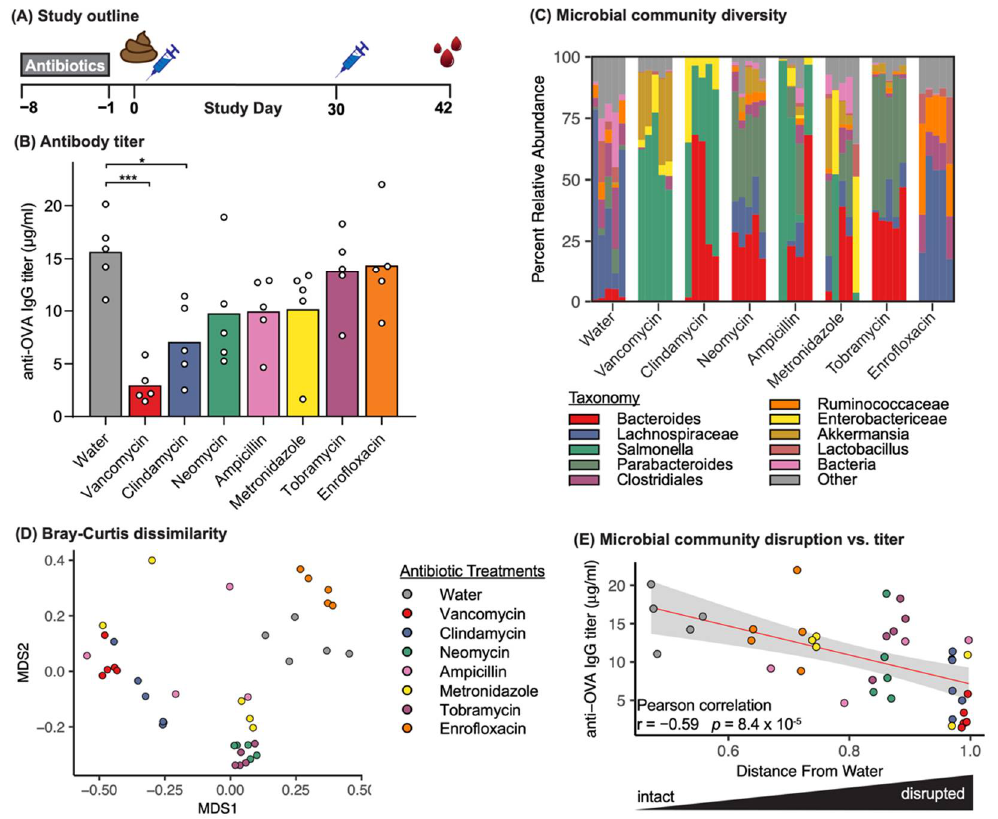
Figure 1. Oral administration of antibiotics differentially affects model sub-unit vaccine outcome and gut microbiome profiles. ( A ) Study design and dosing schedule. BALB/c mice were orally treated with antibiotics for seven days (gray rectangle), followed by a single day of no antibiotic treatment before a prime-boost OVA immunization regimen (blue syringes). Stool collection and harvesting of serum are indicated by brown stool and red icons, respectively. ( B ) Serum OVA-specific IgG titers at Day 42 after immunization. Measurements from individual mice (circles) are superimposed on group mean (bar). * p < 0.05, *** p < 0.001 compared to water by one-way ANOVA with Dunnett’s post hoc test. ( C ) Stacked bar plot of top 10 bacterial genera based on relative abundance determined by 16S rRNA gene sequencing of fecal samples collected at study day 0. Each column represents an individual mouse. ( D ) Non-metric multidimensional scaling (MDS) ordination of mouse microbiome communities with community dissimilarity measured using the Bray–Curtis algorithm. Each point represents the microbiome of an individual mouse; greater distances between points indicate less similar community composition. ( E ) Correlation scatter plot of OVA-specific IgG titer for each individual mouse and distance between the microbial community composition and the average composition of water-treated animals. Red line indicates linear regression line of best fit; gray shading represents 95% confidence interval. The mean microbiome community dissimilarity compared to the average baseline community composition across all groups, calculated using the Bray–Curtis metric and plotted over time. Data are mean and standard error for each treatment